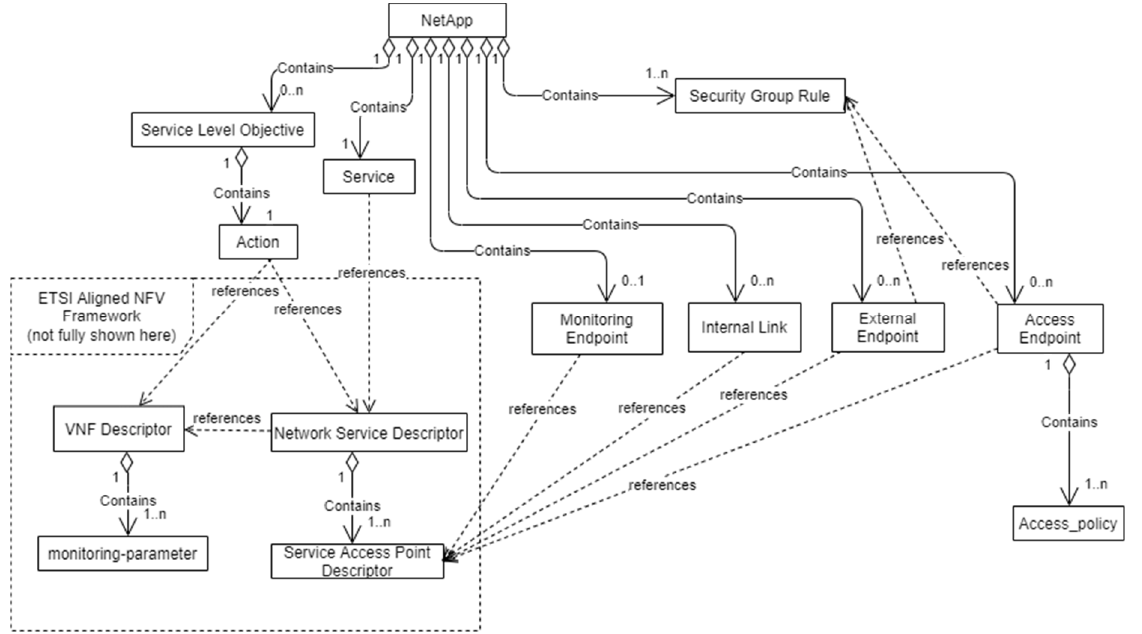
Figure 3. NetApp information model and relation to the ETSI NFV IM.